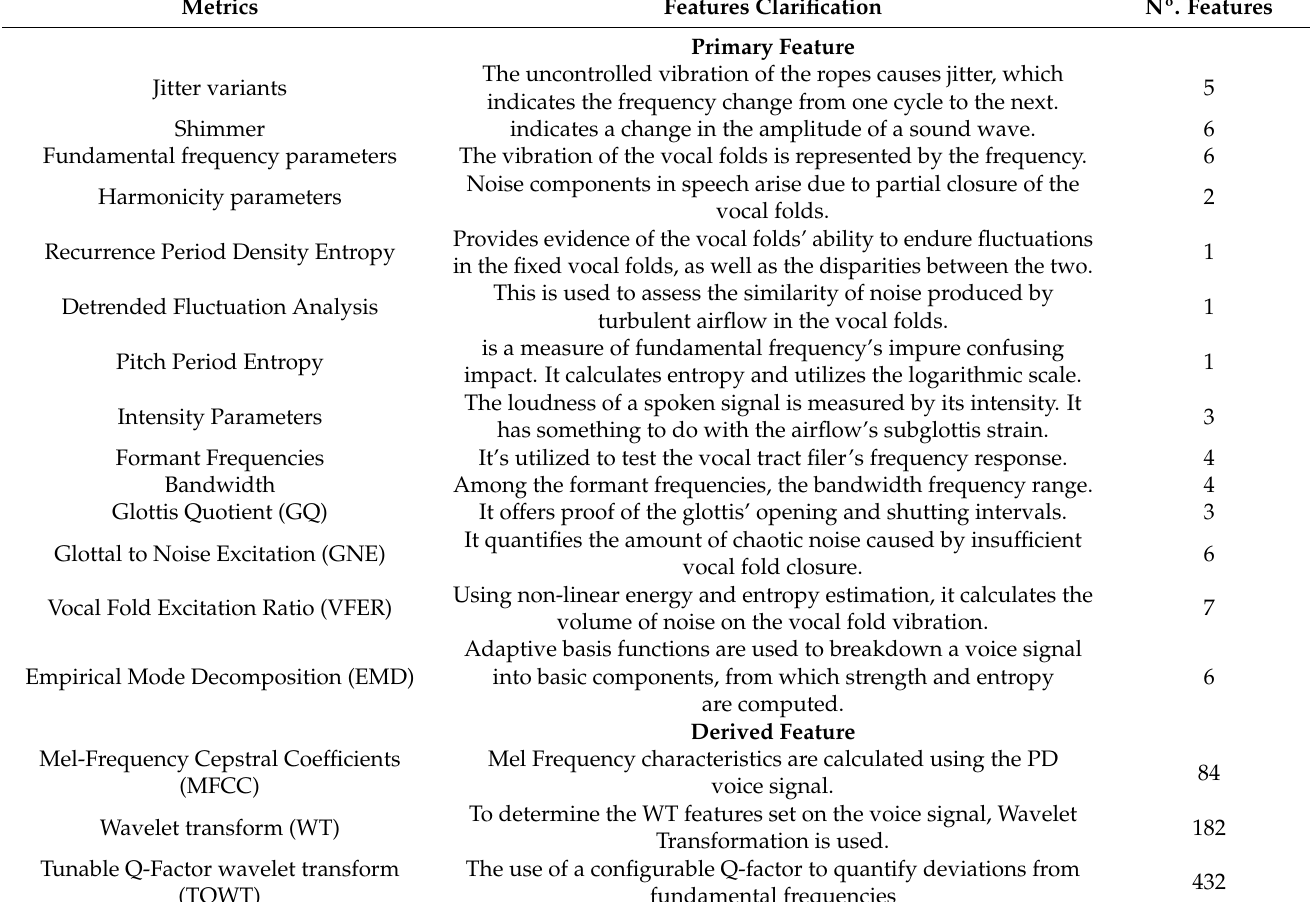
Table 1. PD dataset from UCI.